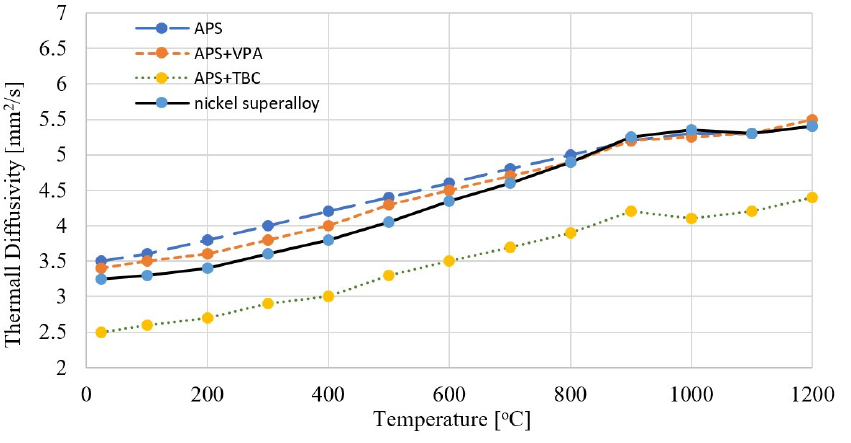
Figure 5. Thermal diffusivity of the blade material (nickel superalloy) of the engine turbine and protective coatings.